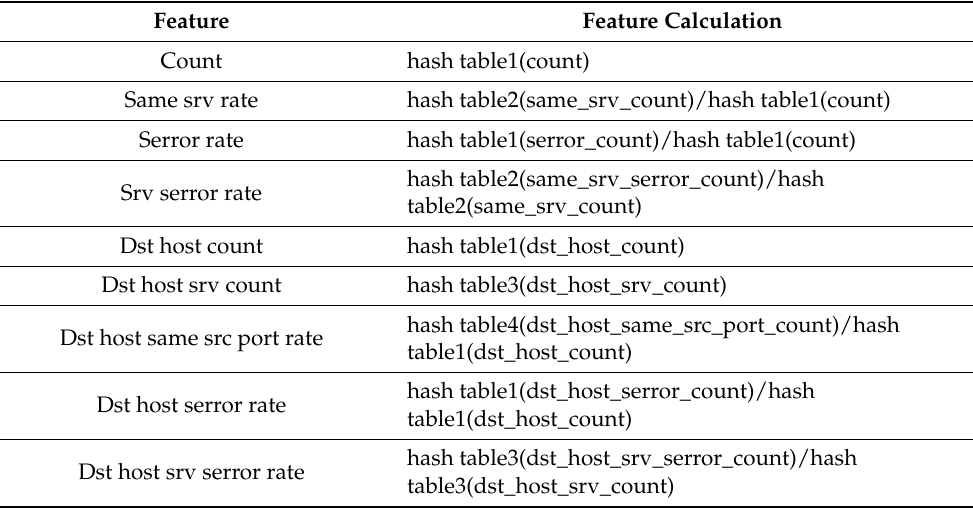
Table 6. List of multi-host features and their calculation expressions. hash table k (f) means the value of the field f in the entry of the k -th hash table matching with the given